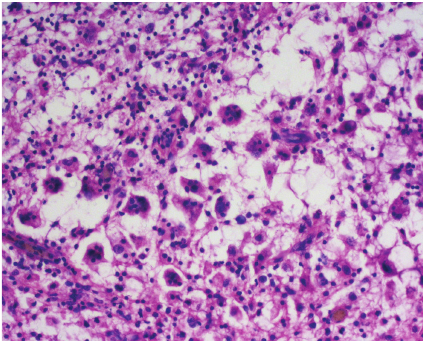
Figure 3: Photomicrograph of the lesion showing many histiocytes, some of which have engulfed intact lymphocytes (H&E, × 400).